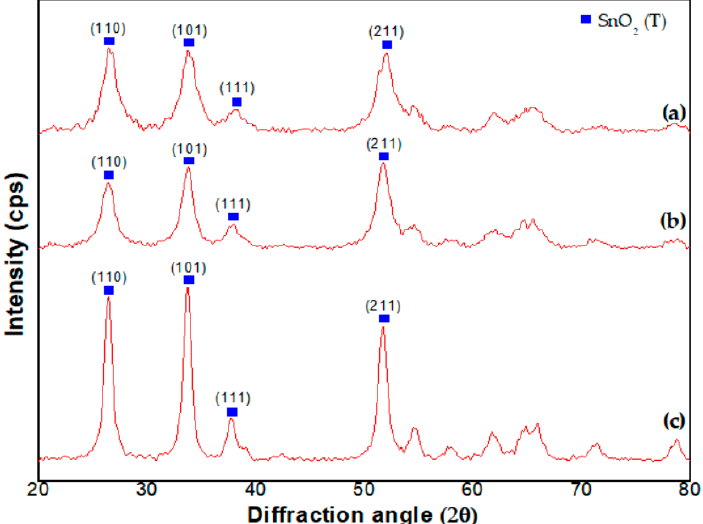
Figure 5. X-ray diffraction peaks of crystal structure of the SnO 2 -Pd NPs after heat-treatment at ( a ) 300 °C, ( b ) 500 °C and ( c ) 700 °C, respectively.